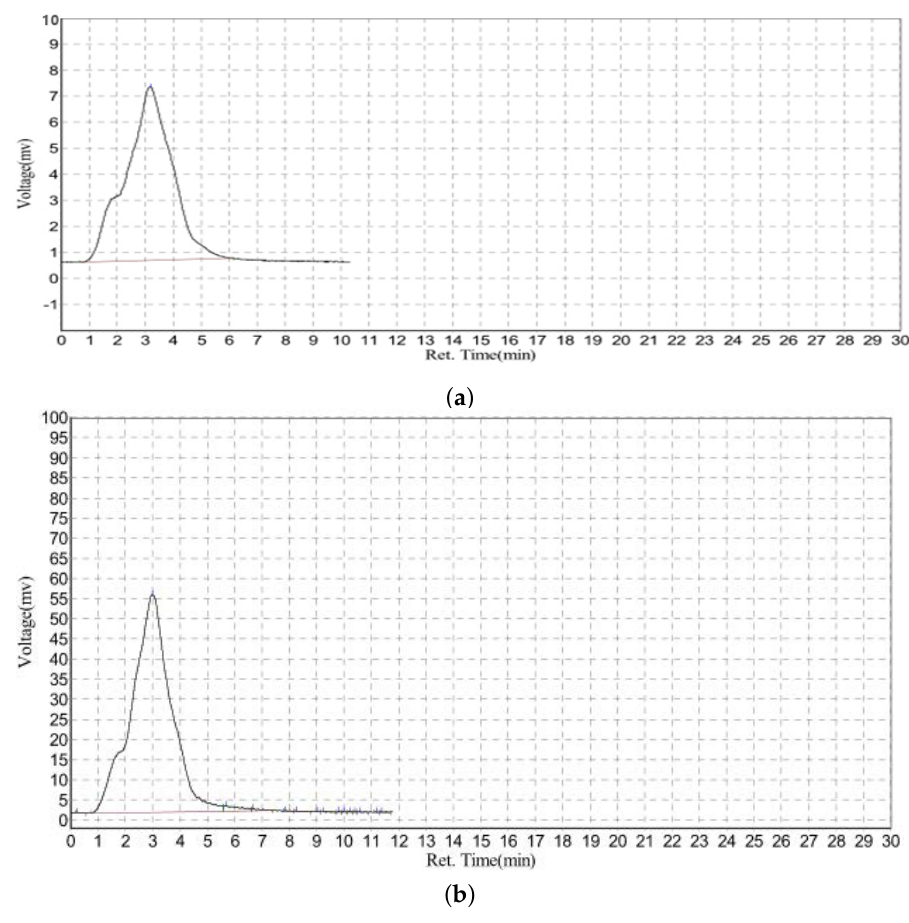
Figure 5. Rapid GFC analysis of ( a ) lecithin liposome-encapsulated TiO 2 nanoparticles (1 mg/mL), using ( a ) λ ex = 365 nm and λ em = 460 nm; and ( b ) λ ex,max = 350 nm and λ em,max = 395 nm, for FD.